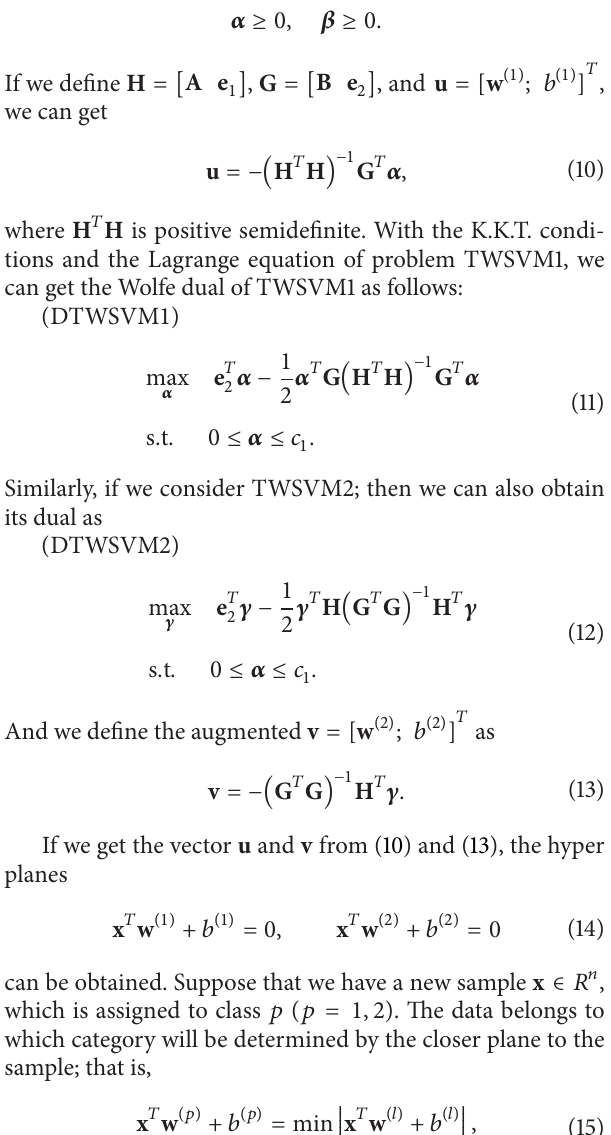
Algorithm 1 (MCs detection and classification based on